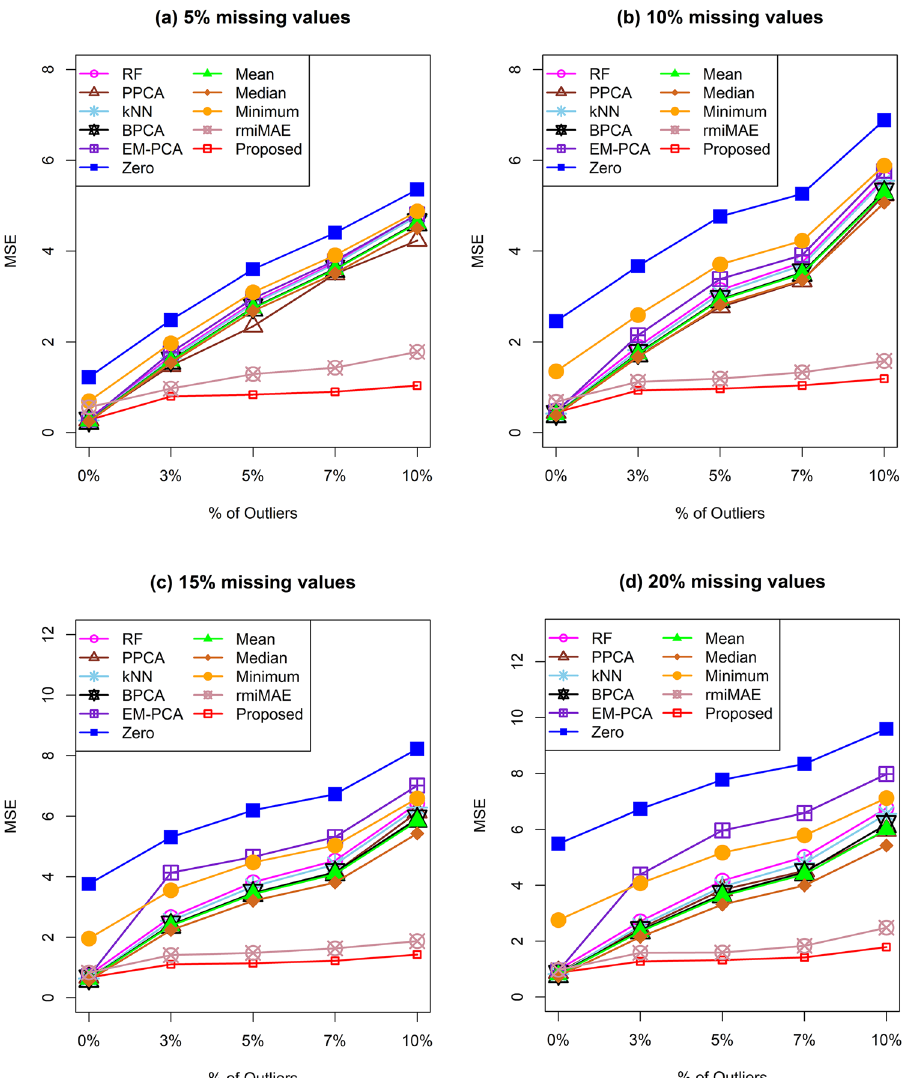
Figure 1. Performance investigation of different missing imputation techniques using average MSE for without class level